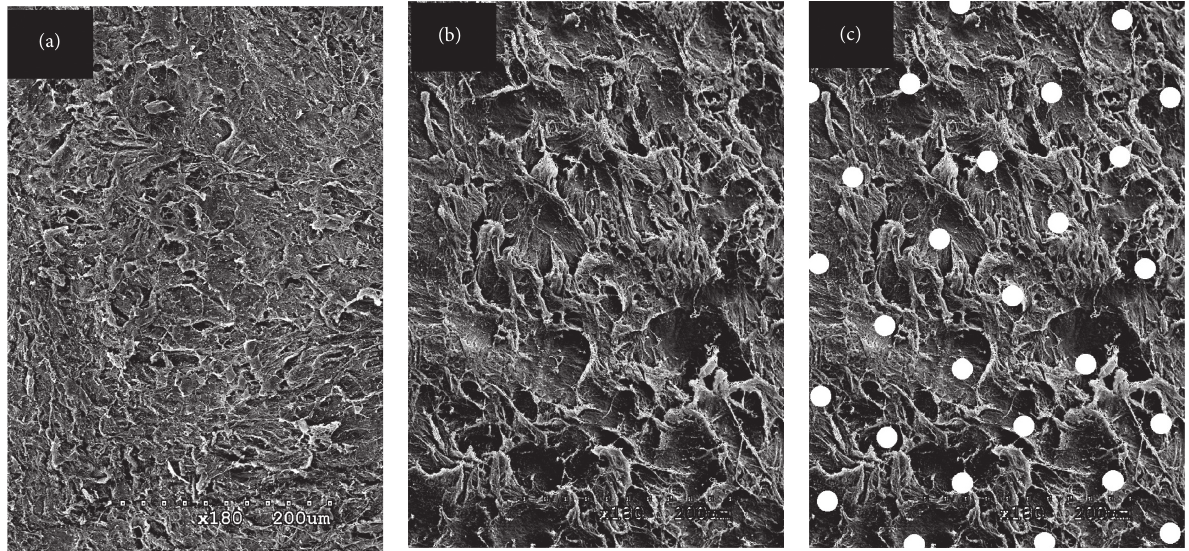
Figure 3: Suspected traces of cavitation bubbles on the lenticule surfaces under scanning electron microscope, × 180 magnification. (a), (b) The posterior lenticule surfaces created by Femto LDV Z8 and VisuMax, respectively. Compared with (a), the rougher surface of (b) was speculated to be caused by cavitation bubbles during VisuMax SMILE surgeries. (c) The white spots were artificially marked on (b) to show the sites of suspected traces of cavitation